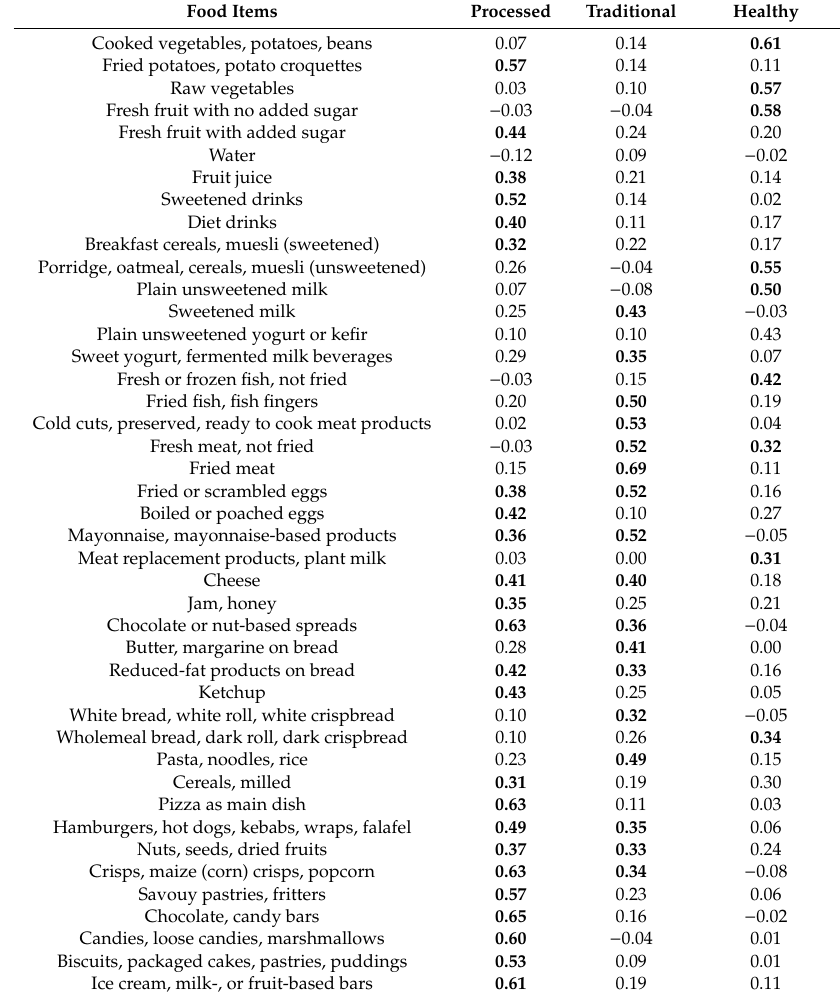
Table 2. Principal components and factor loadings.